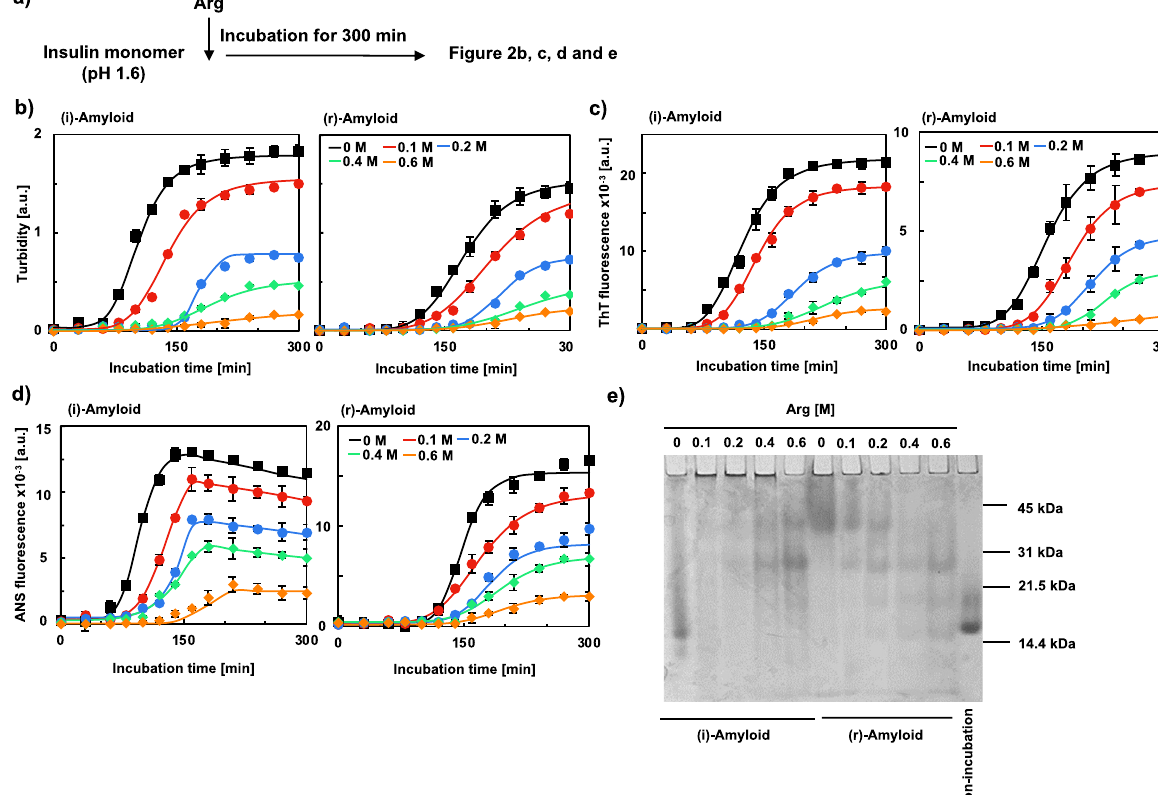
Figure 2. Evaluation of the effect of arginine on the formation of insulin amyloids. ( a ) Experimental scheme of ( b–e ). (i)-amyloid (left) and (r)-amyloid (right) were formed in the absence and presence of 0.1, 0.2, 0.4, 0.6 M Arg (black, red, blue, green, and orange, respectively), and were evaluated by Turbidity ( b ), ThT ( c ) and ANS ( d ) fluorescence intensity. Graphs of ( c ) and ( d ) are fluorescence values in emission wavelength (ThT, 490 nm; ANS, 480 nm). Protein concentrations were adjusted to 5 µM. ( e ) Native-PAGE analysis of 150 μM (i)-amyloids and (r)-amyloids formed in the absence and presence of 0.1, 0.2, 0.4, 0.6 M Arg. The rightmost sample is an unincubated native